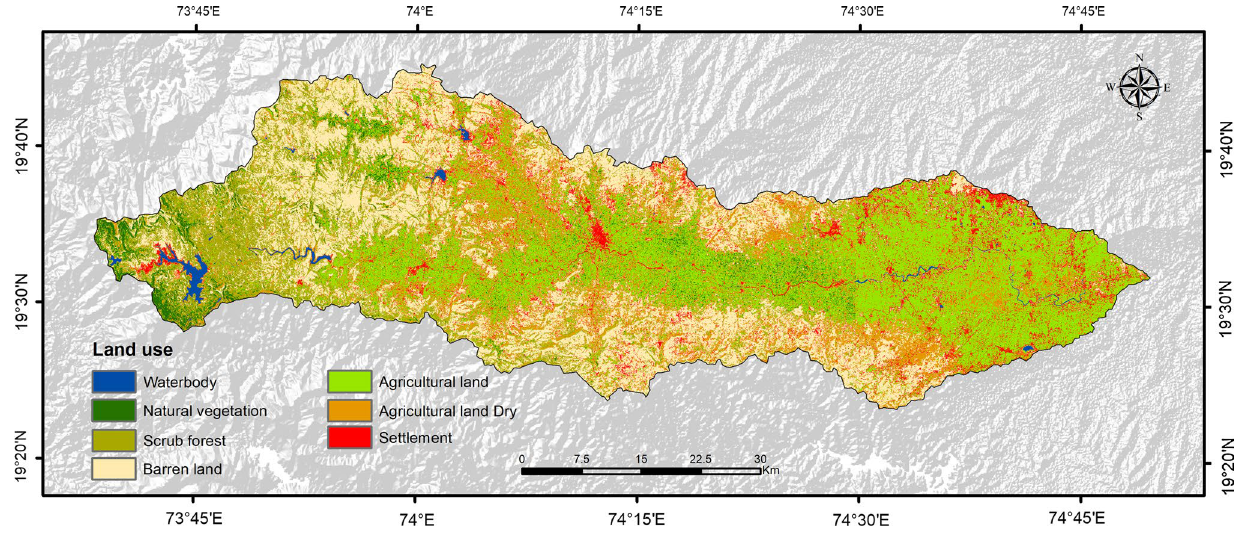
Fig. 6 Land-use map of the study